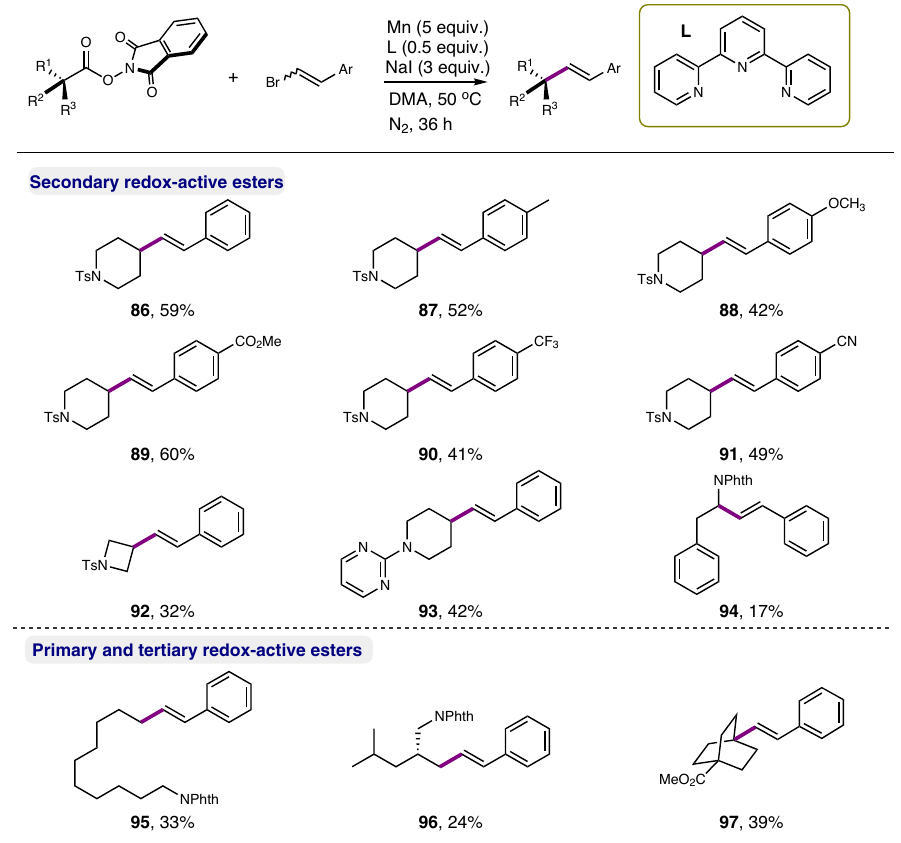
Fig. 7 Scope of decarboxylative vinylation. Reaction conditions: NHPI ester (0.2 mmol), bromoethylene (0.6 mmol), 2,2 ′ :6 ′ ,2 ″ -terpyridine (0.1 mmol), NaI (0.6 mmol), Mn (1.0 mmol), in DMA (0.4 M), 50 °C, N 2 , 16 h; yields are for isolated